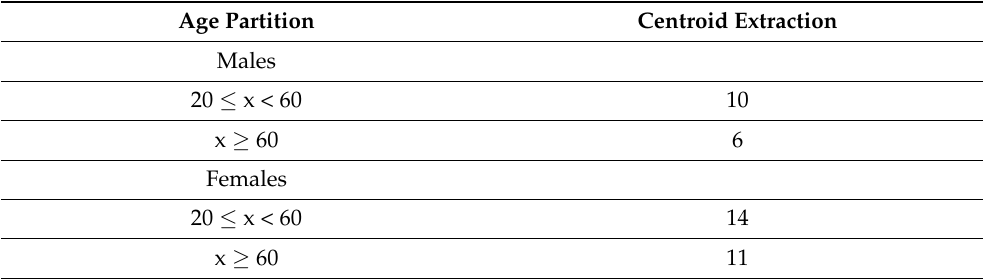
Table 5. Optimal